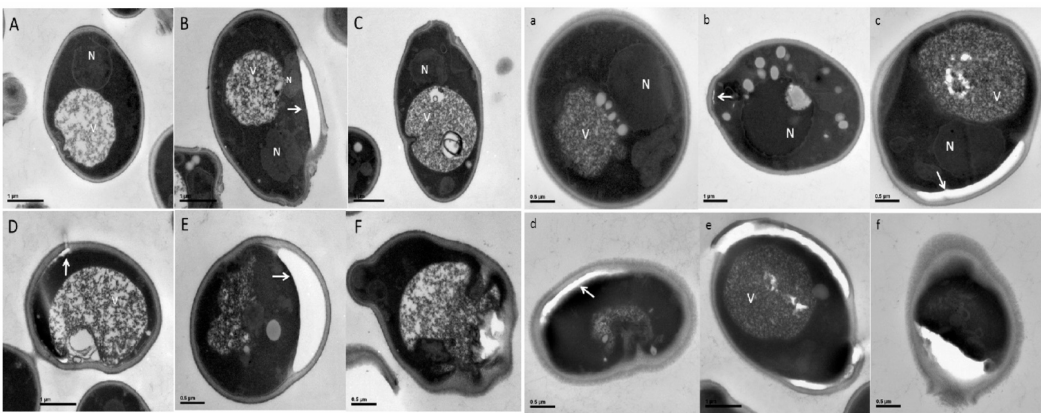
Figure 5. Electron microscopy images of S. cerevisiae . Upper graphs were the wild-type yeast groups; Lower graphs were the ∆ pep4 yeast groups. ( A , a ), the control group; ( B – F ), wild-type cells; ( b – f ), ∆ pep4 cells. Cells were treated with 20 µ g / mL of BetA for 4 h. Bar, ( A – D , b , e ), 1 µ m; ( e , f , a , c , d , f , E , F ), 0.5 µ m. Arrows show the vesicles on the outer side of the plasma membrane.